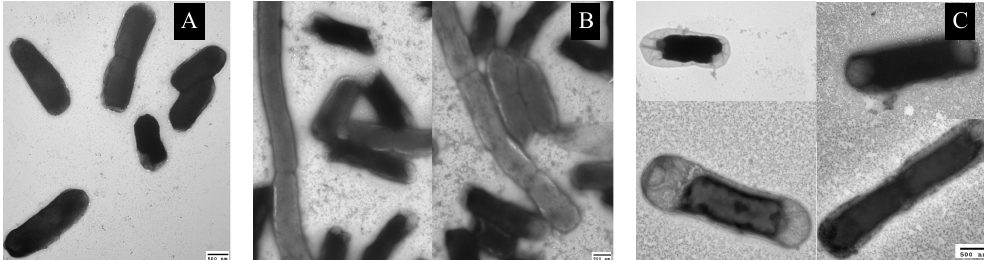
Figure 5. TEM images of E. coli at MgSO 4 concentrations of ( A ) 2 mM, ( B ) 1.25 M, and ( C ) 2.07 M, respectively. Cells undergo plasmolysis at high salt concentrations and the extent of plasmolysis is greater near the